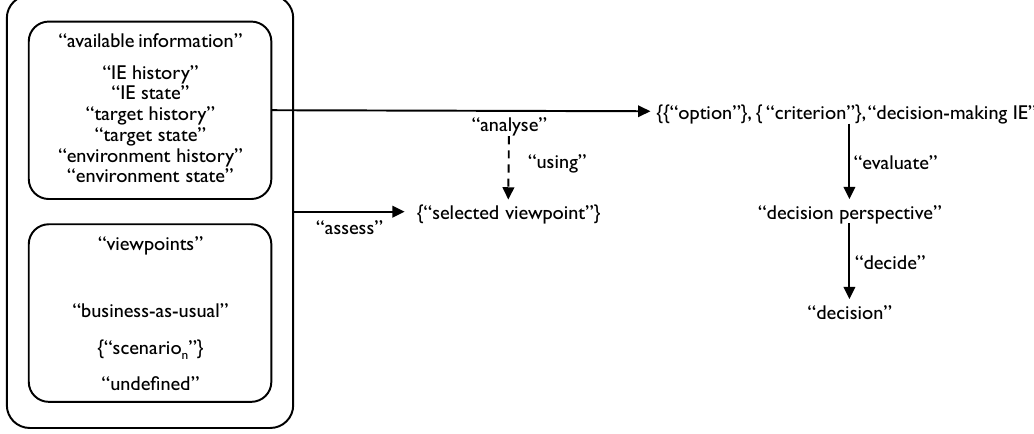
Figure 2. An information evolution model of